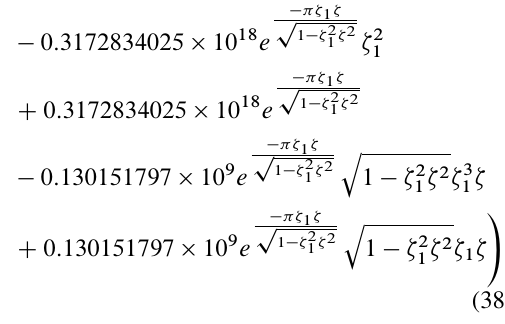
Figure 4. The value of spring ratio k D k 2 =k 1 versus (cid:28) D l=v to have near flat ride with ideal nonlinear damping, for different " D a 1 =l